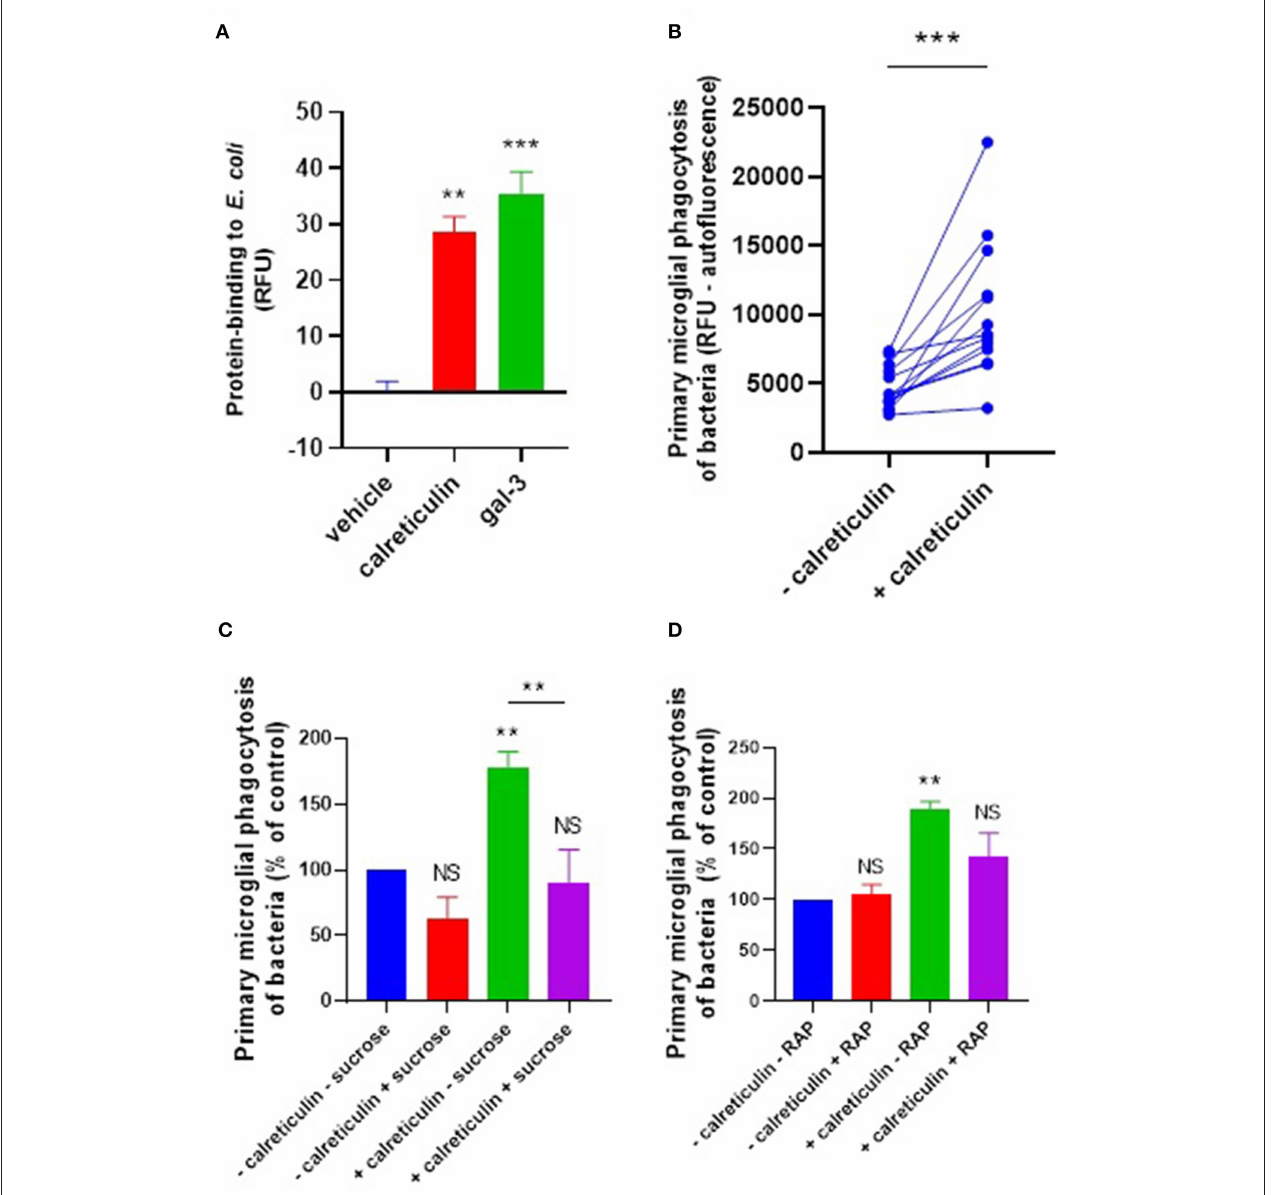
FIGURE 3 | Calreticulin opsonizes E. coli for microglial phagocytosis. (A) TAMRA-conjugated calreticulin (500nM) and galectin-3 (20nM) bind E. coli after 90min co-incubation, measured in terms of relative fluorescence unit increase vs. the vehicle (protein-free) control. (B) Recombinant calreticulin (500nM) opsonizes E. coli for microglial phagocytosis when pre-incubated for 90min (and subsequently washed to remove unbound protein). (C,D) Opsonization of E. coli for microglial phagocytosis by recombinant calreticulin is inhibitable by 50mM sucrose when compared to “–calreticulin – sucrose” control (C) or 500nM RAP (a LRP1 inhibitor) when compared to “–calreticulin – RAP” control (D) . Values are means ± SEM of at least three independent experiments. Statistical comparisons were made via one- or two-way ANOVA except for (B) , which was by pair-wise student’s t -test. NS p ≥ 0.05, ** p < 0.01, *** p < 0.001 vs. controls, except where indicated by bars over relevant